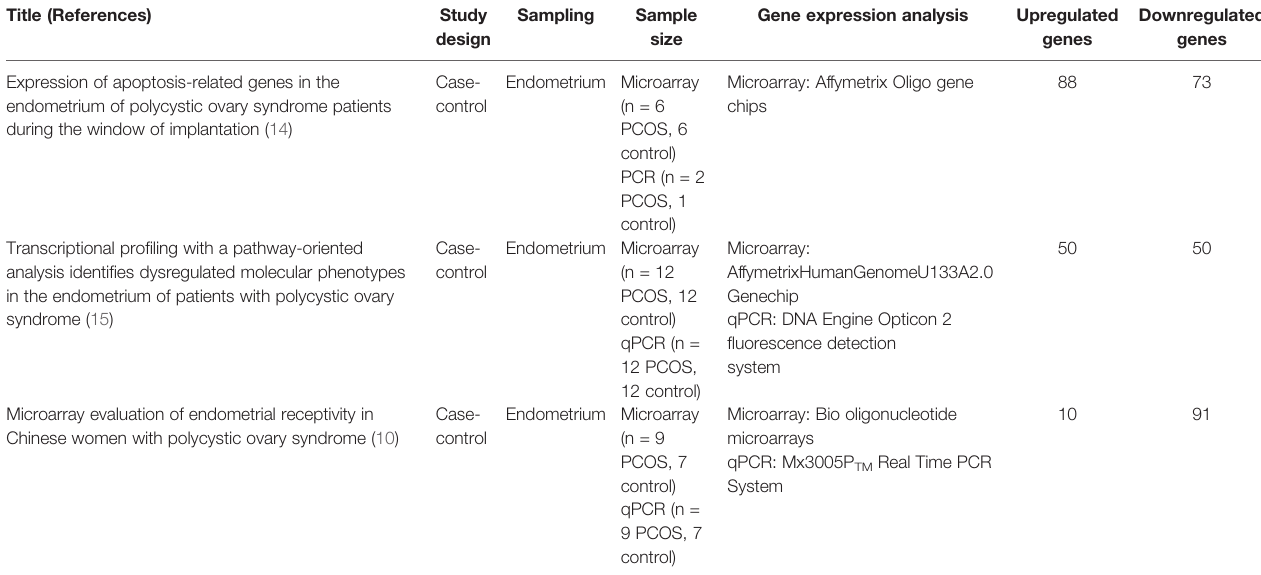
TABLE 1 | Summary of selected